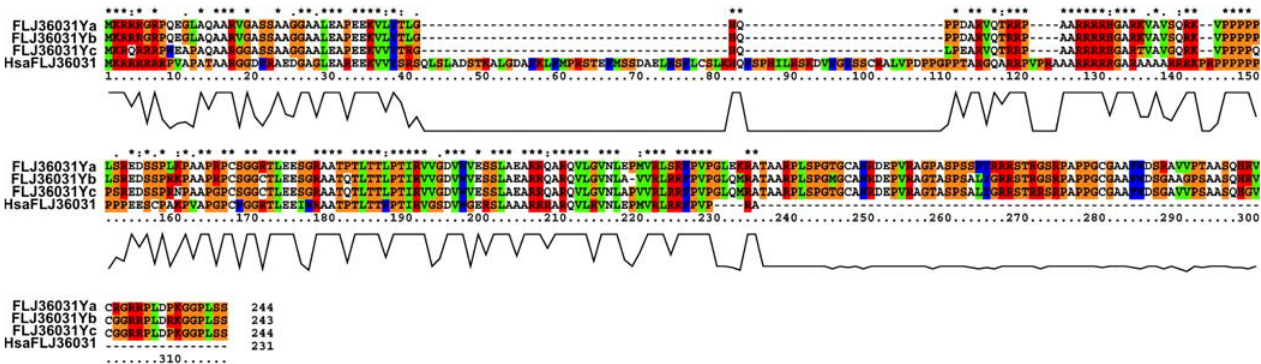
Figure 2. Alignment of Predicted Amino Acid Sequences for Three Feline FLJ36031Y Genes and Human Autosomal FLJ36031 Above the alignments, asterisks indicate sites that are conserved. Below the alignments are histograms displaying level of amino acid conservation across the alignment. Note that the human FLJ36031 protein contains a long stretch of mostly unique amino acids from position 40 to 111, whereas the carboxyl terminus of the feline FLJ36031Y proteins (positions 232–318) is unique. DOI: 10.1371/journal.pgen.0020043.g002